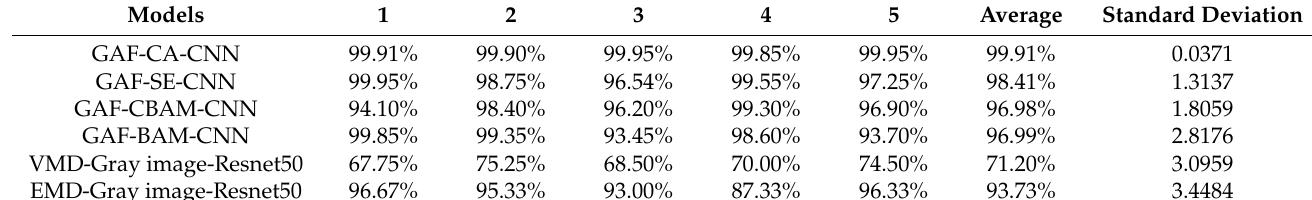
Table 8. Diagnostics result of different methods on Dataset B.